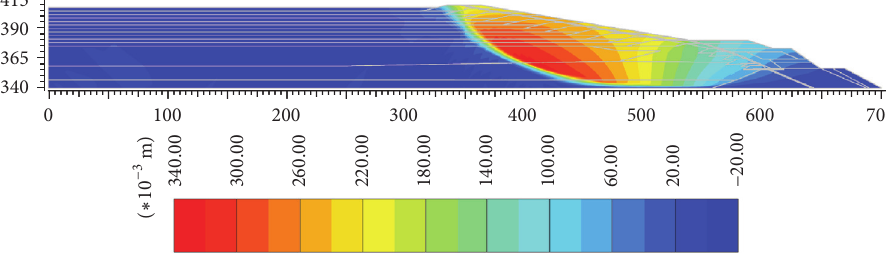
Figure 15: Horizontal displacements in the dam after shaking with normal earthquake. The positive direction is to the right.